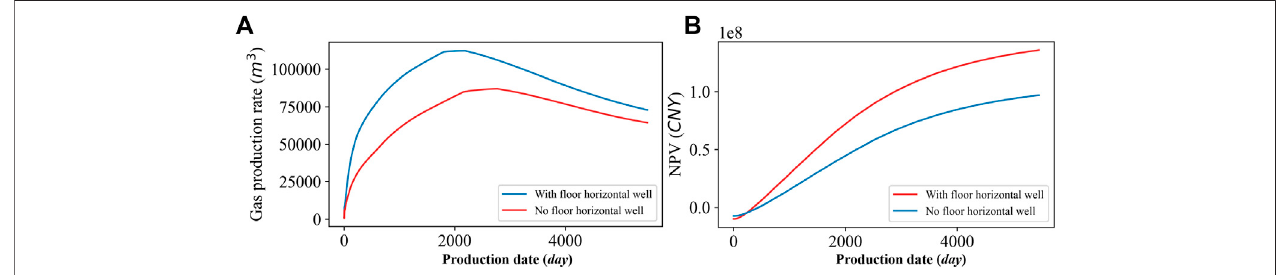
FIGURE 12 | Comparison of the simulation cases: (A) Gas production rate, (B) NPV.